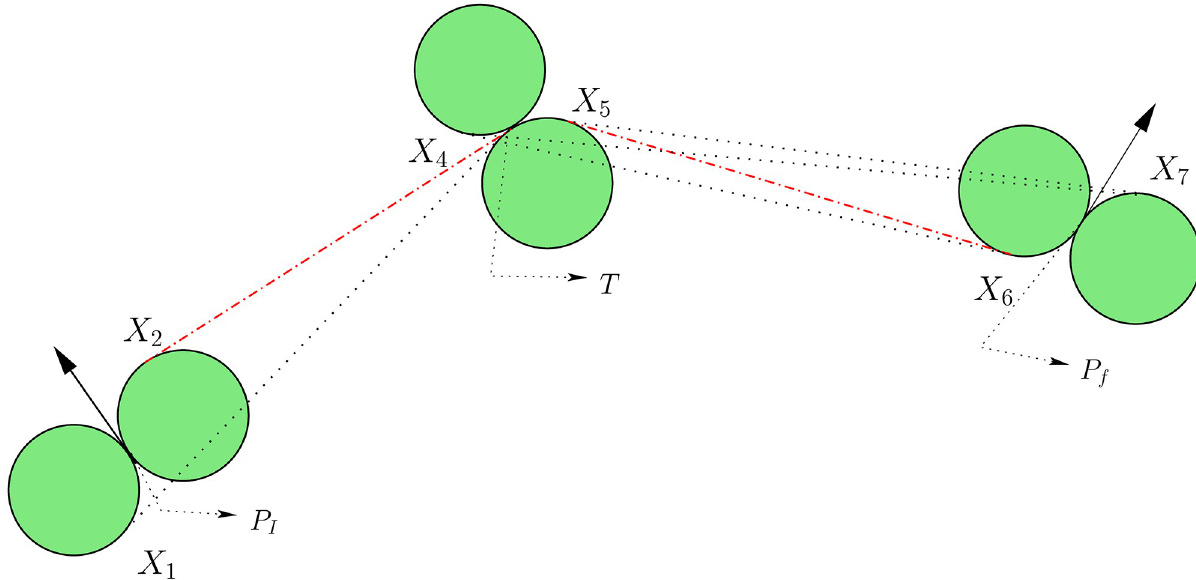
Fig 1. Feasible optimal paths of UAV for single target